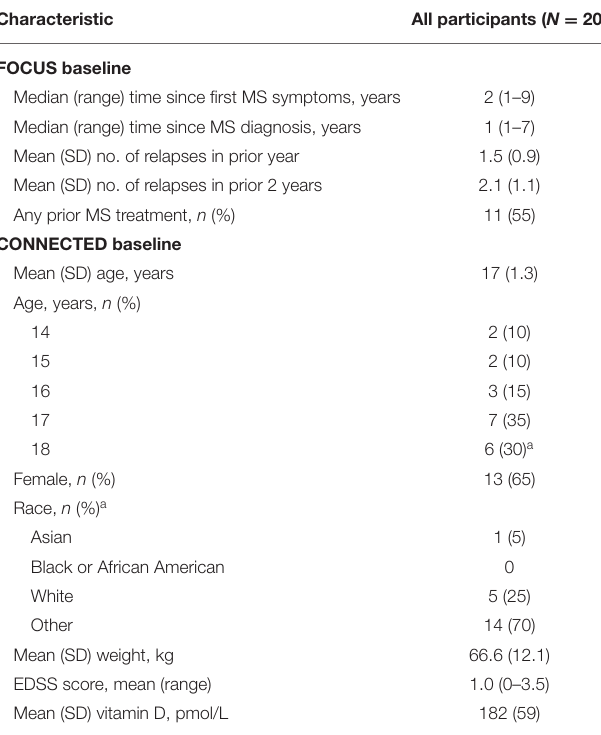
TABLE 1 | Baseline demographics (CONNECTED and FOCUS) and disease characteristics. Characteristic